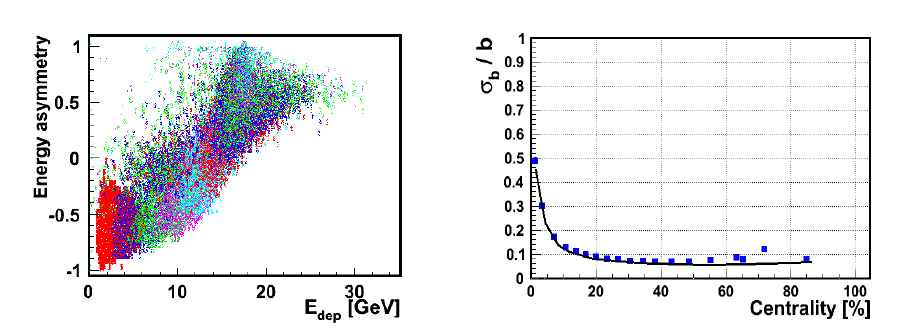
Figure 8. (Left) The reconstructed energy asymmetry in the FHCal as function of energy deposition when the energy of fragment spectators in the calorimeter beam hole is taken into account. Here, di ff erent colors correspond to 10% of the centrality bins. (Right) Dependence of centrality resolution of FHCal with beam hodoscope in the beam hole as function of